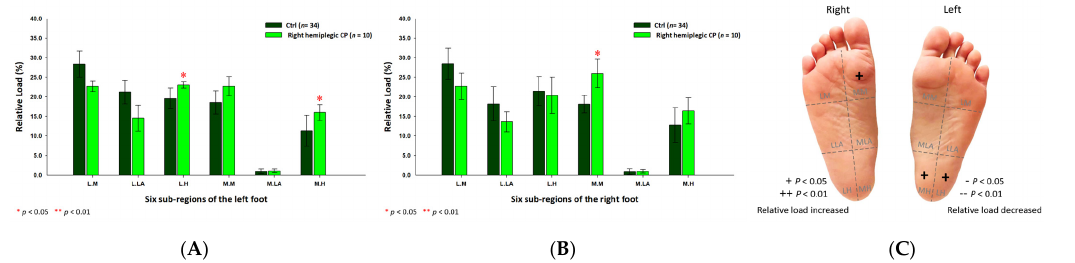
Figure 10. The percentage of six subregional relative loads of ( A ) left and ( B ) right feet in female students during static stance. The changes in pressure distribution are illustrated in ( C ) foot plantar diagram. Significant differences between the female control group and the female right hemiplegic CP group were determined as * p < 0.05 and ** p < 0.01.